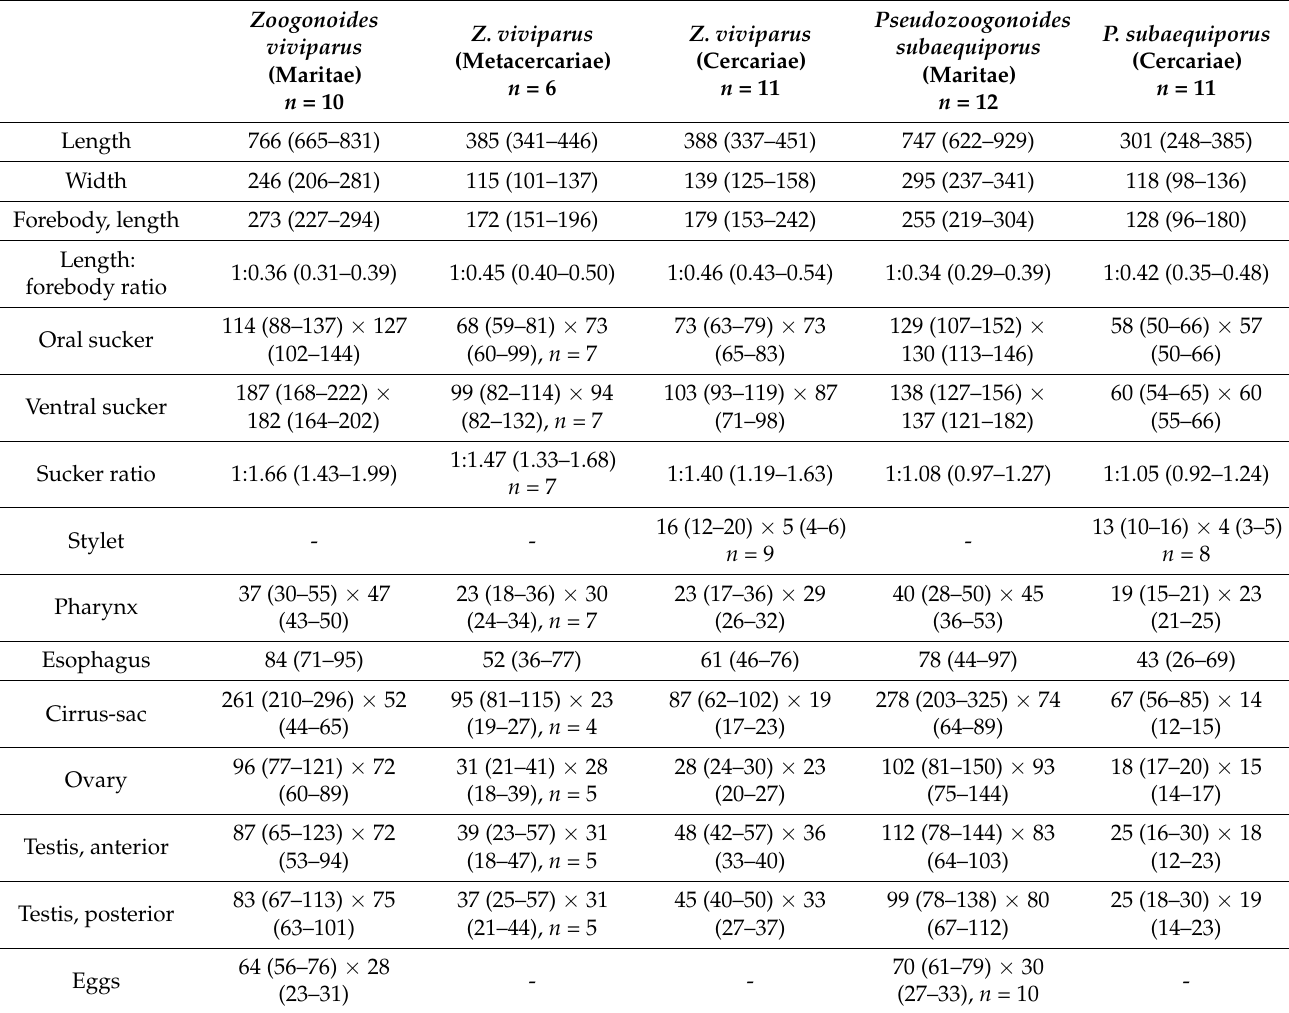
Table 4. Dimensions of the White Sea Zoogonidae life cycle